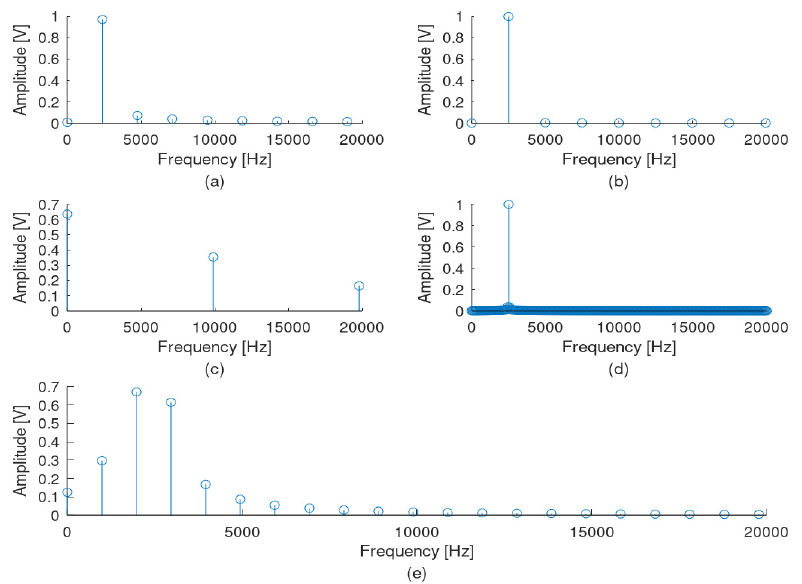
Figure 8. FFT results for the sine signal at 2.5 kHz in the frequency domain, when different observation windows at the time domain are used. Observation time intervals are ( a ) 0.42 ms, ( b ) 0.4 ms, ( c ) 0.1 ms, ( d ) 1 ms and ( e ) 1.01 ms.